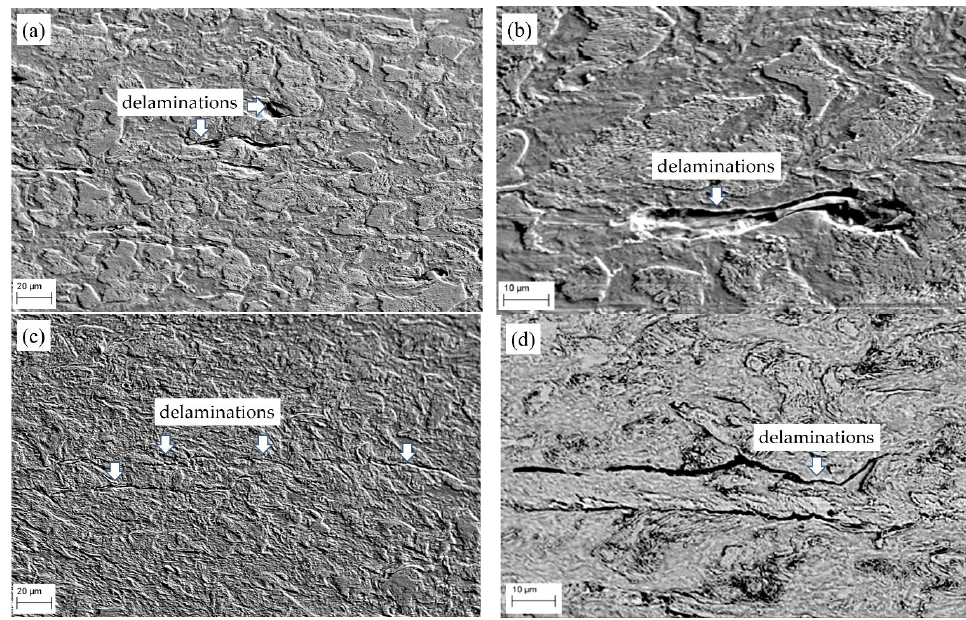
Figure 5. SEM microstructure of the LTO steel cut from ( a , b ) the upper part of the pipe (position T, zone II in Figure 1a) and ( c , d ) its lower part (position B, zone III in Figure 1a) close to its inner surface. Delaminations are indicated by arrows.